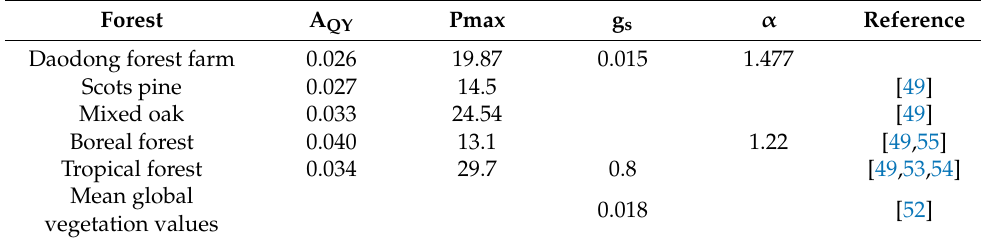
Table 2. Physiological ecosystem